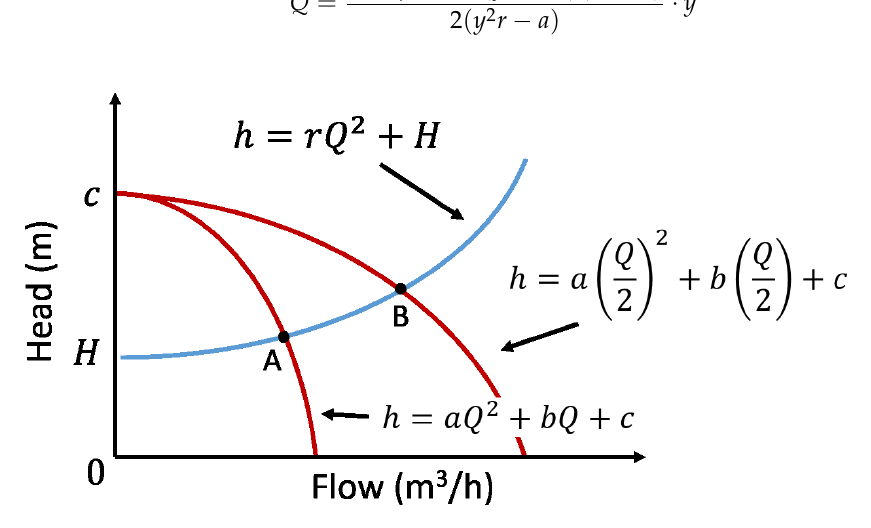
Figure 2. Physical properties of the water